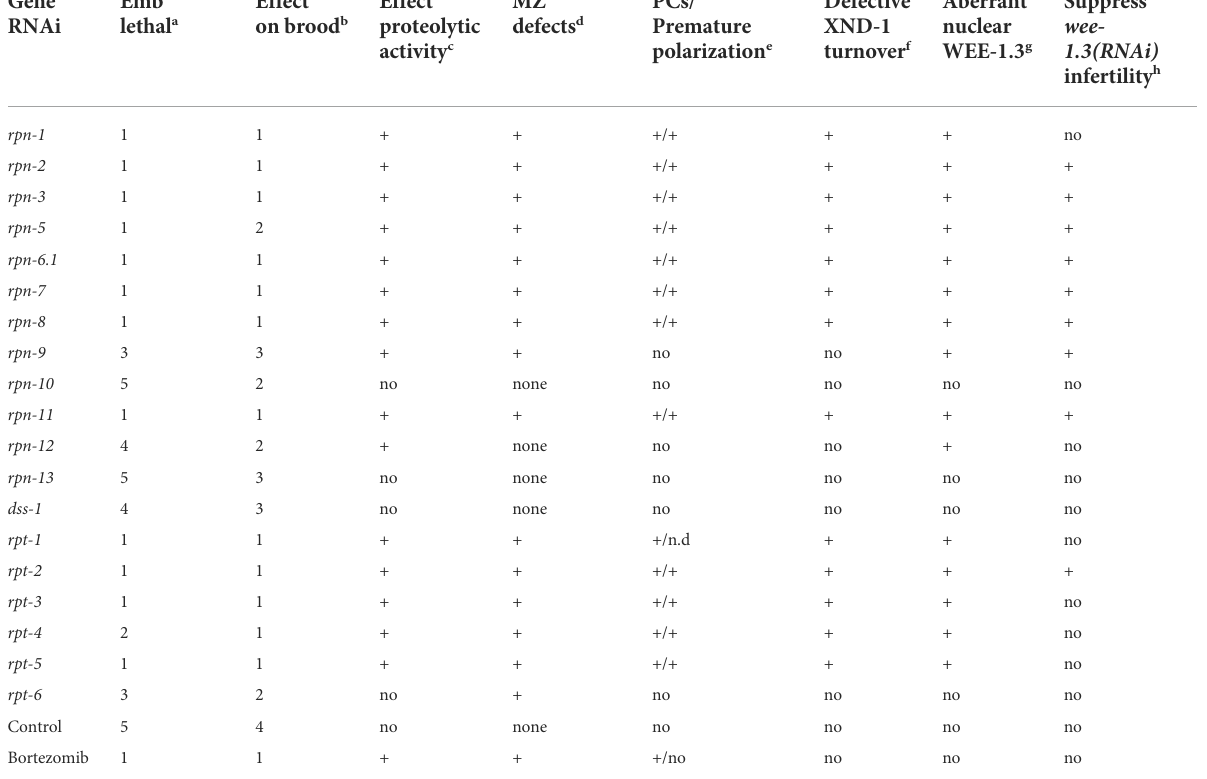
TABLE 2 Summary of the germline phenotypes associated with RNAi-depletion of the various 19S RP